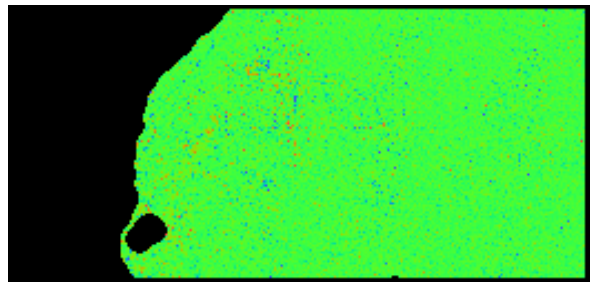
Figure 10: Radargrammetric control map for the Raw DEM op- erationally processed. The black area corresponds to the phase unwrapping error, spanning the 24% of the scene.